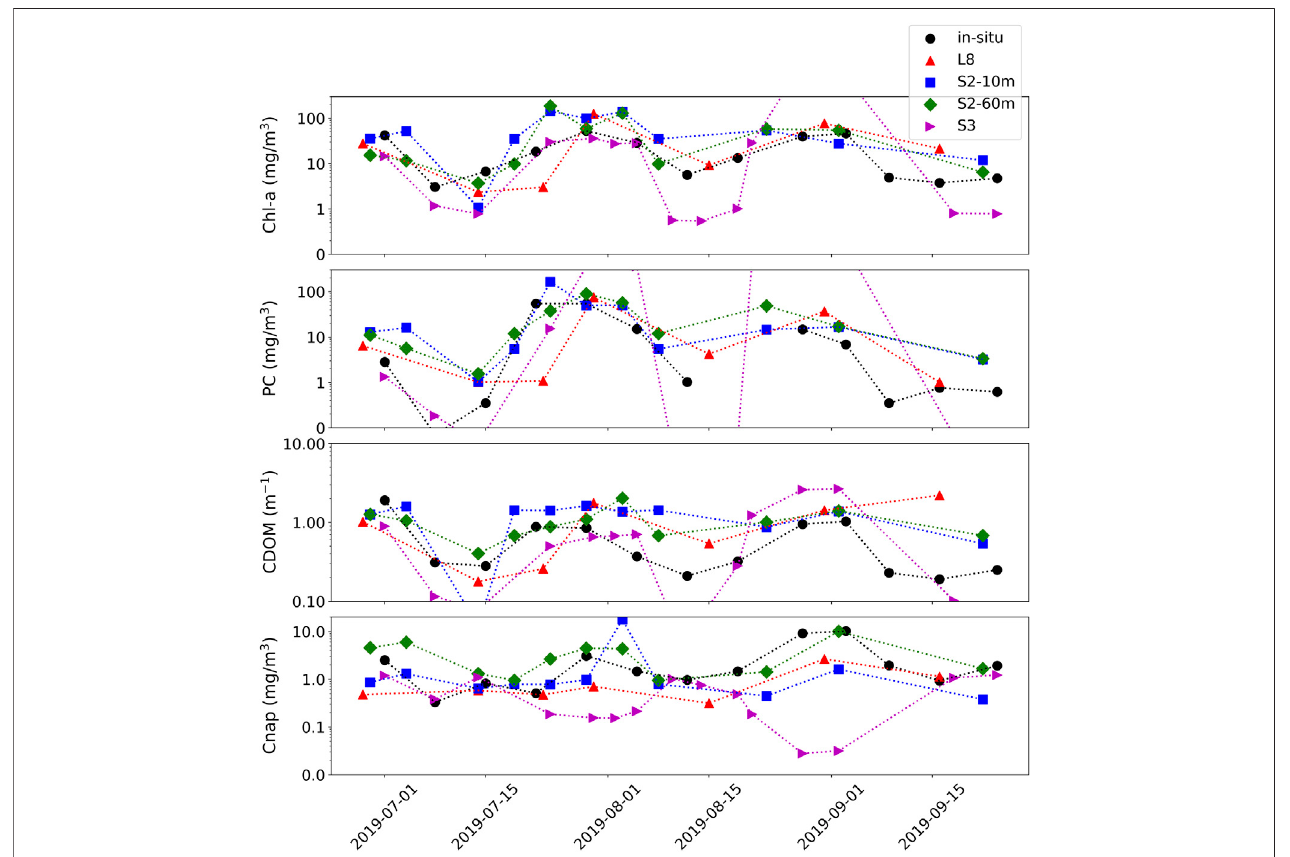
FIGURE 11 | Time-series of station WE4 from western Lake Erie. Product retrievals are derived from MLP from S3, S2, and L8 using TOA re fl ectance data (colors) plotted with in-situ data (black) from NOAA GERL and NCEI.